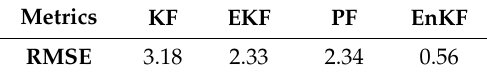
Figure 8. The history matching results of the acceleration in the Y-direction ( a y ). Table 1. The RMSE value of the Kalman filter (KF), extended Kalman filter (EKF), particle filter (PF) and EnKF (units: